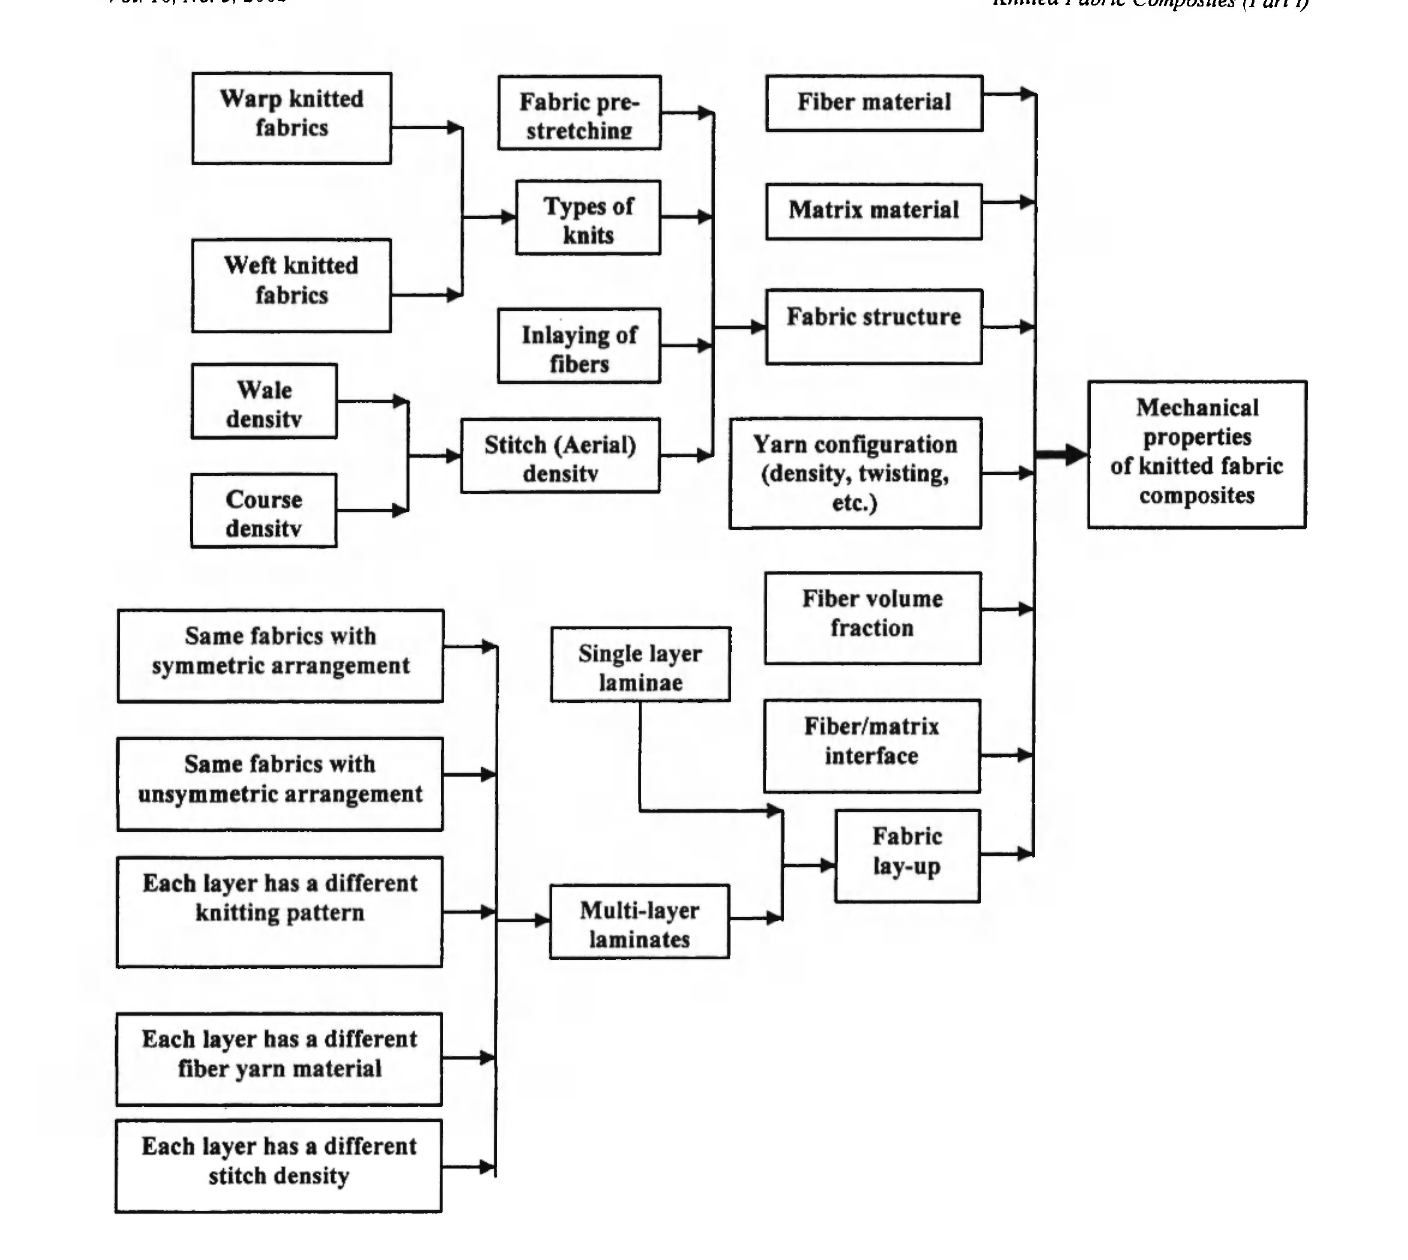
Fig. 16: An overview of various variables that influence the mechanical properties of knitted fabric composites, in which the warp and weft knitted fabrics are further classified in Figs. 17 and 18.